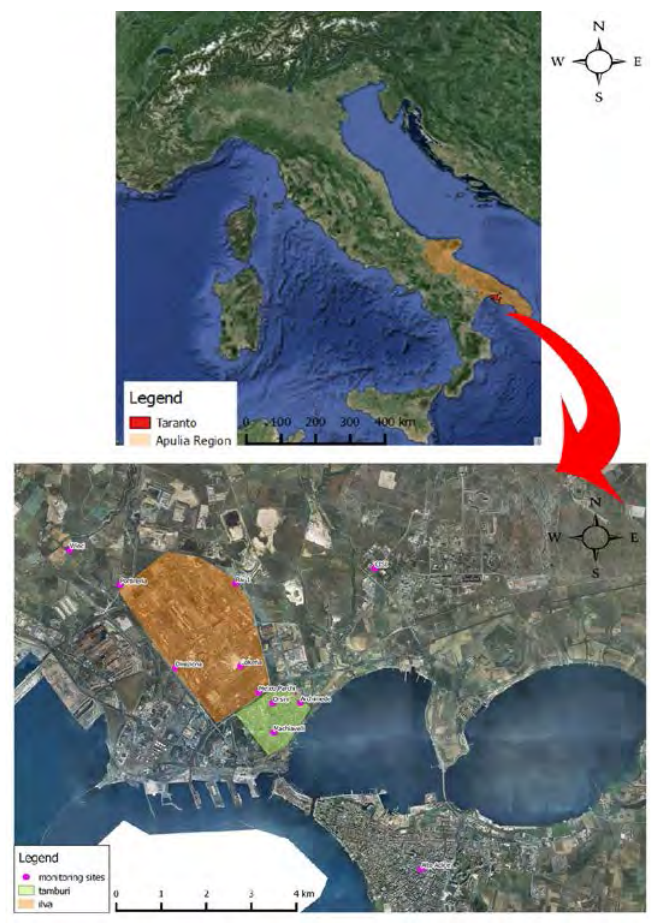
Fig. 1: Taranto air quality monitoring